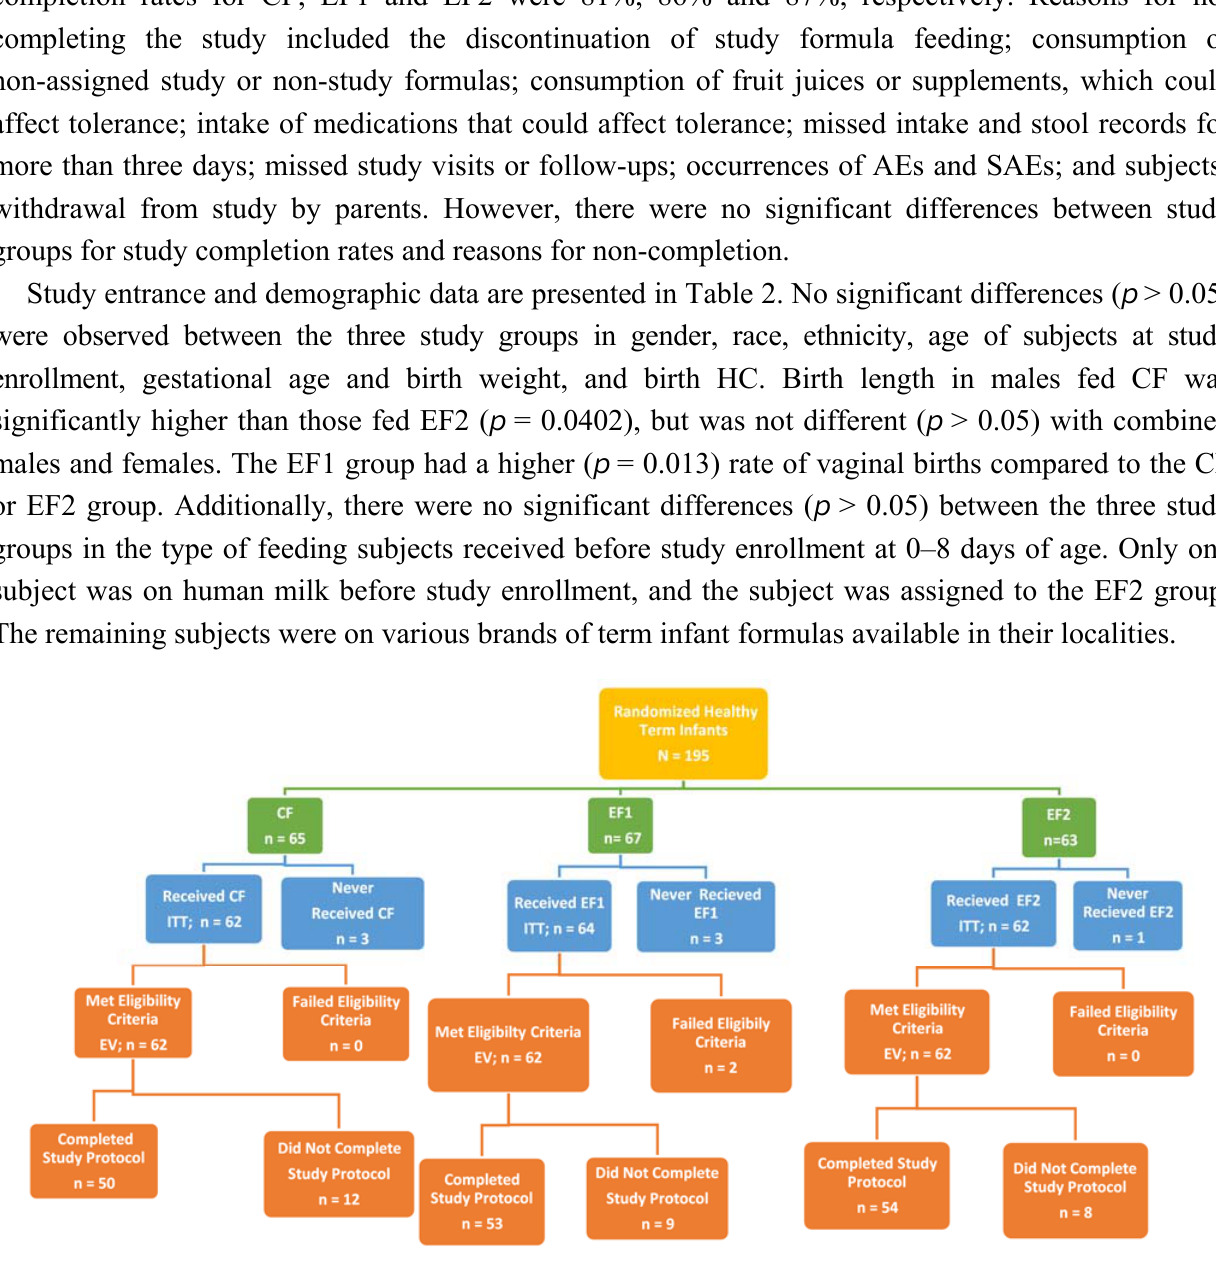
Figure 1. Flow chart of the disposition of study subjects. Abbreviations: CF = Control formula, EF1 = Experimental formula 1, EF2 = Experimental formula